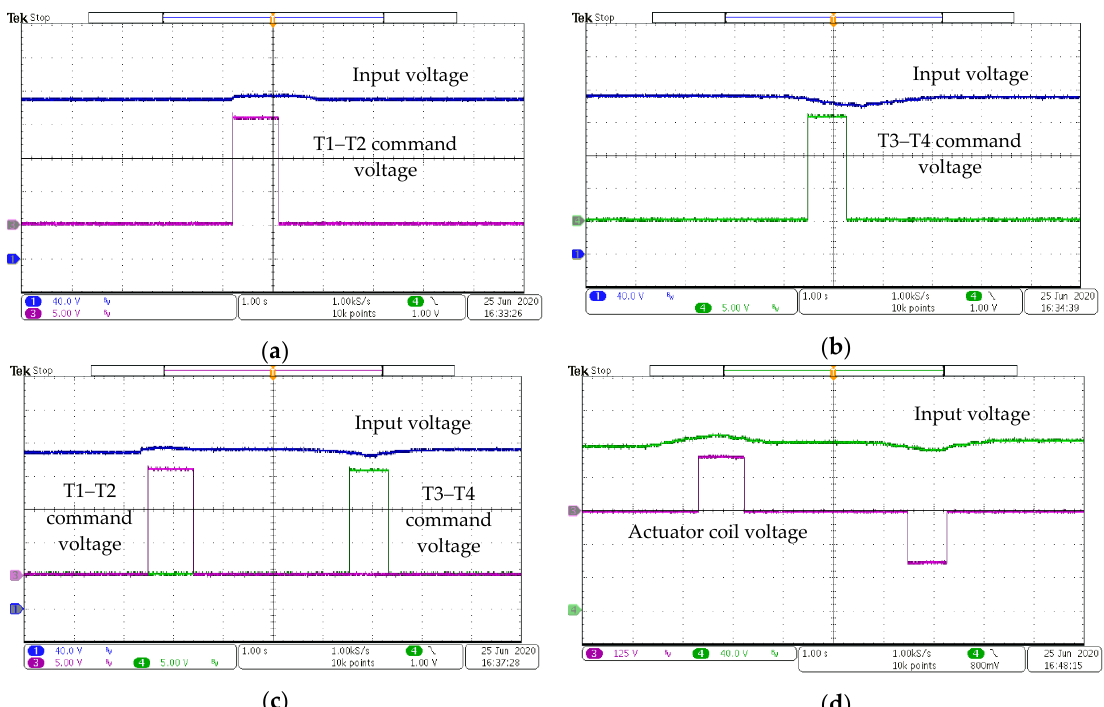
Figure 11. Working principle waveforms of the bipolar current angular command with a limited